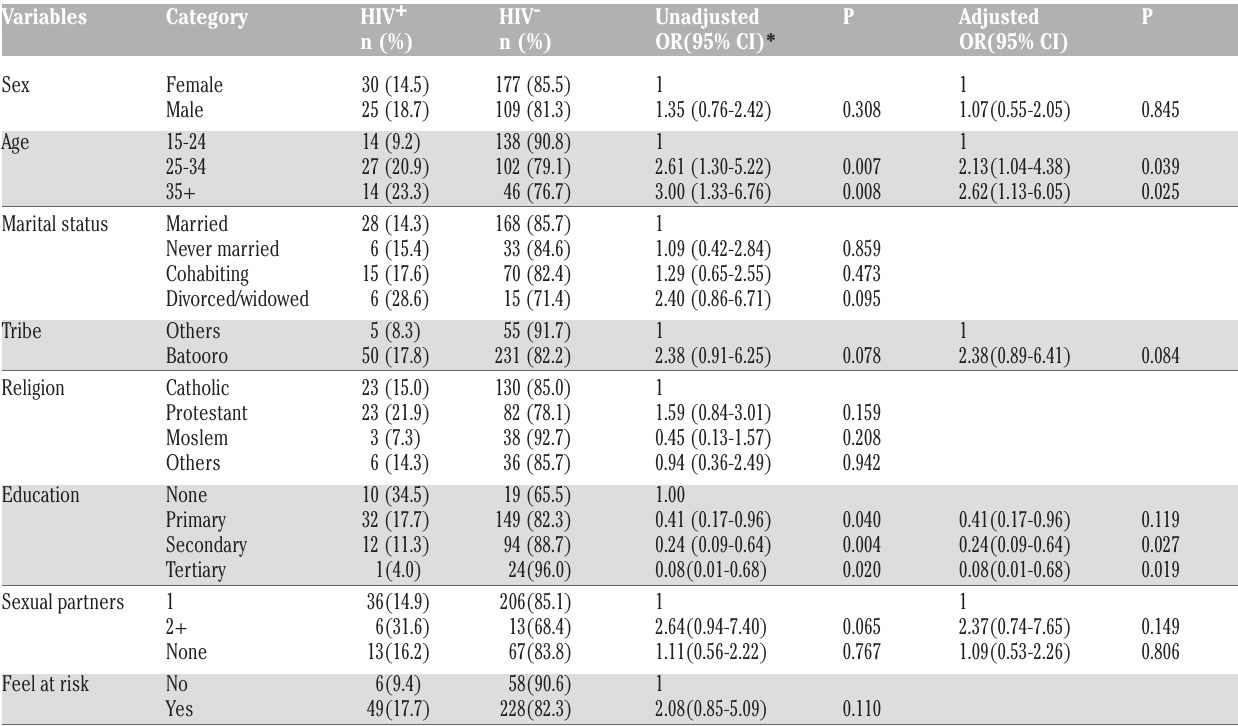
Table 1. Unadjusted and adjusted factors associated with HIV prevalence in Fort-Portal municipality.